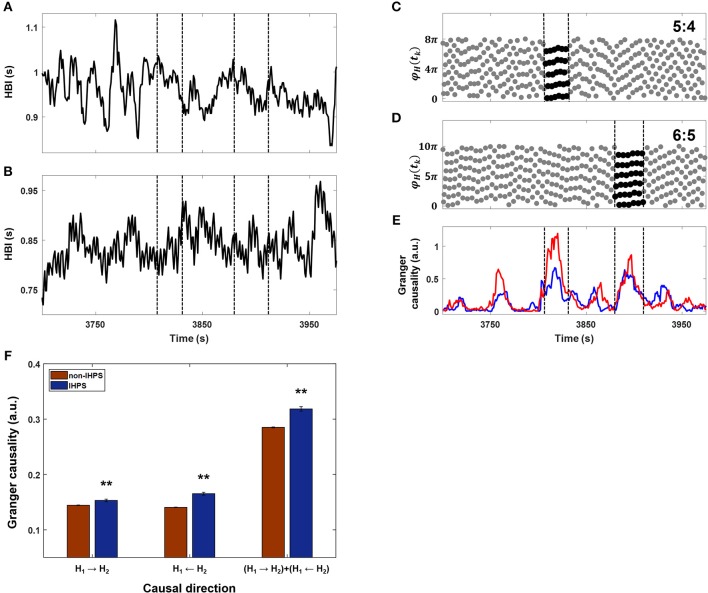
Comparison between IHPS at a Δ of 4 and IHCR. (A) The heartbeat intervals (HBI) from one subject for ~250 s. (B) The HBI from a co-sleeper for the corresponding time duration. (C) The synchrogram determined by heartbeats in (A) and (B) (gray dots) and IHPS with a ratio of 5:4 (black dots between vertical lines). (D) The synchrogram determined by the corresponding heartbeats (gray dots) and IHPS with a ratio of 6:5 (black dots between vertical lines). (E) The IHCR directions from HBI in (A) to HBI in (B) (blue line) and from HBI in (B) to HBI in (A) (red line). The periods of IHPS with ratios of 5:4 and 6:5 are marked with vertical dashed lines, indicating that IHCR increases in both directions in the IHPS condition. (F) Comparison of IHCR between IHPS (blue bars) and non-IHPS (red bars) observed in all co-sleeping individuals during the entire recording. IHCR shows a significant increase in both directions during IHPS. The summation of both directional influences is also significant. The error bars indicate the standard error. The independent samples t-test revealed **p < 0.001 for all three cases. IHPS was associated with an increased level of bidirectional influences that provide fine tuning of each frequency and phase.